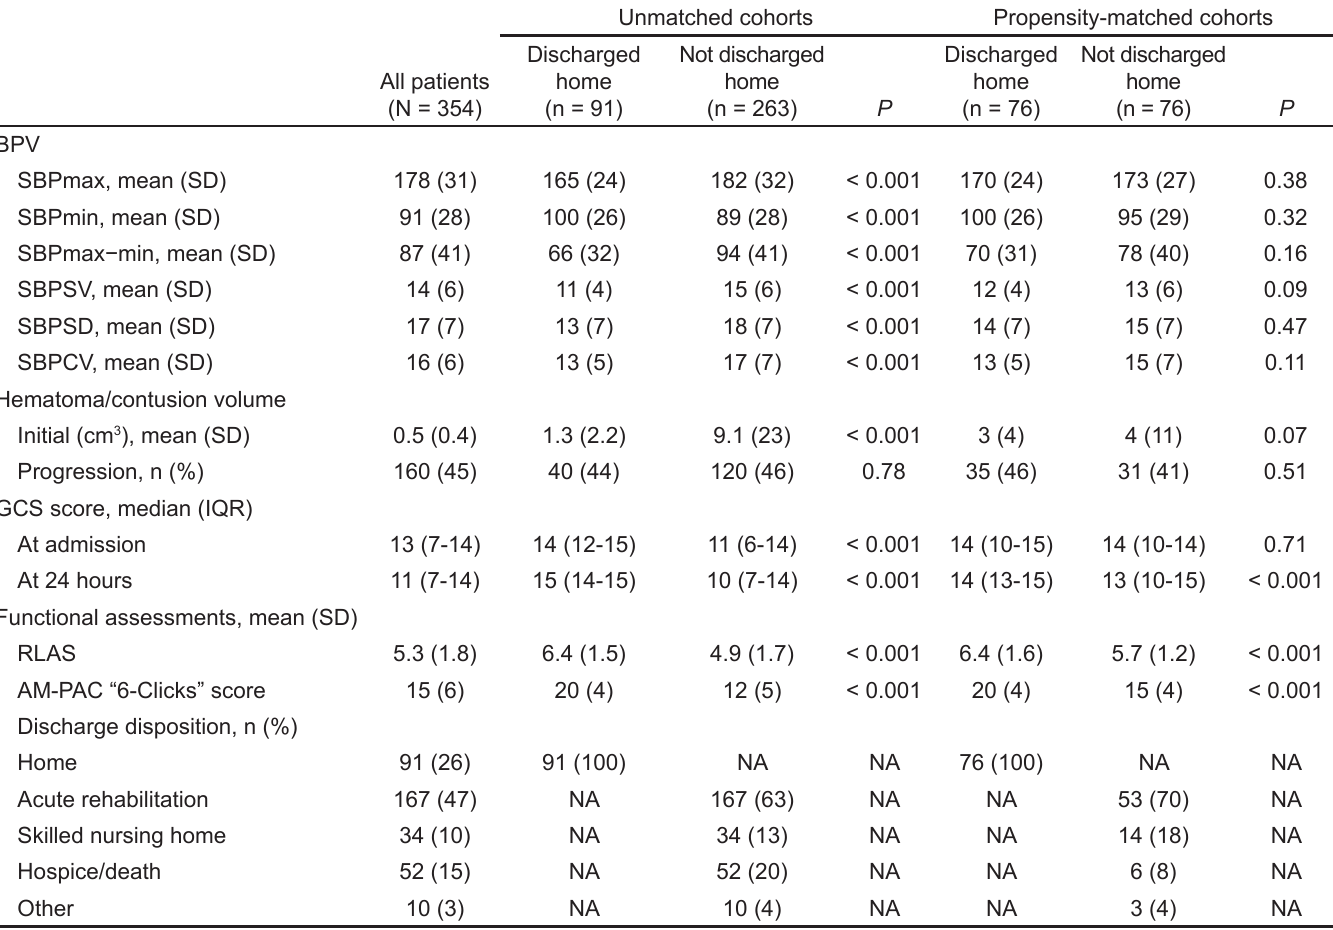
Table 3. Comparison of clinical characteristics by discharge location, matched and unmatched cohorts. Unmatched cohorts Propensity-matched